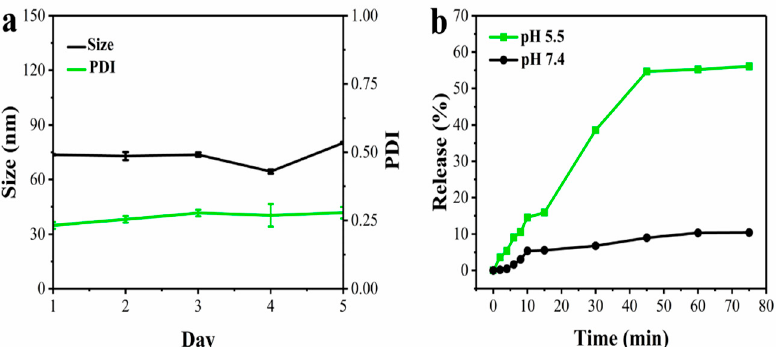
Figure 2. Stability and PDI determination of Cel-ZIF-8 NPs. ( a ) Stability of Cel-ZIF-8 NPs under physiological conditions (pH 7.4). Particle size (green) and PDI (black) were recorded continuously for 5 days. ( b ) Cel release curve of Cel-ZIF-8 NPs measured at pH 7.4 (black) and 5.5 (green). n = 3, error bars represent standard deviation of the 3 trials.